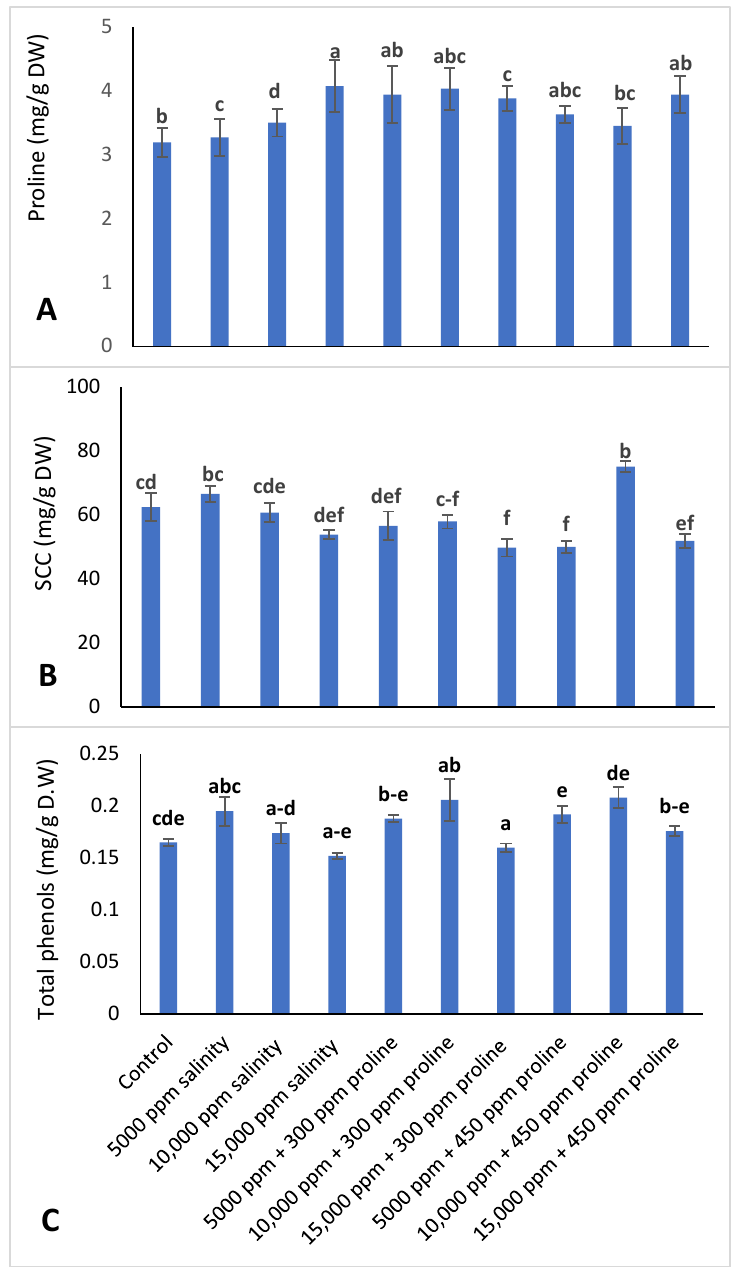
Figure 8. Effect of different levels of seawater salinity and exogenous proline at three concentrations, 0 ppm, 300 ppm, and 450 ppm, on proline content (mg/g DW) ( A ), soluble carbohydrate content (SSC) (mg/g DW), ( B ) and total phenol content (mg/g DW) ( C ). Data are means of two seasons (2020 and 2021) and three replicates ( n = 3) each season. The mean values ± SE of each parameter followed by different alphabetical letters are significantly different according to Duncan’s multiple range test at p ≤ 0.05.